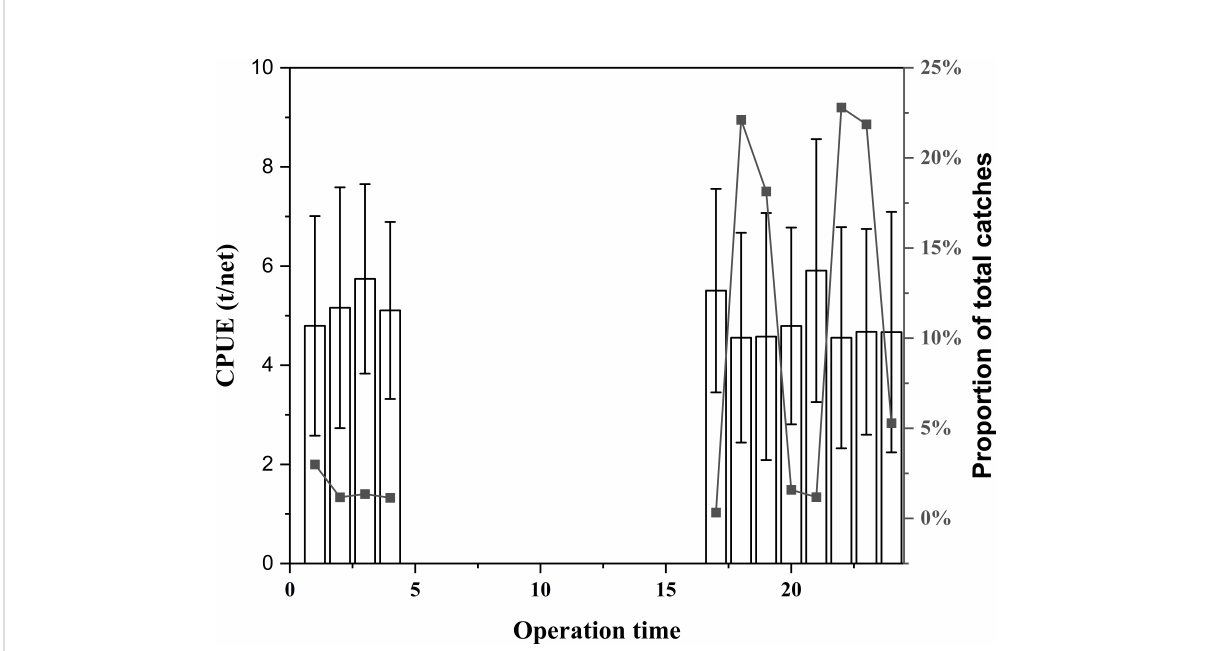
FIGURE 6 Variation in the proportion of total catches (line) and CPUE (bar) of light falling gear in the Northwestern Indian Ocean under the operation time scale (mean ± standard